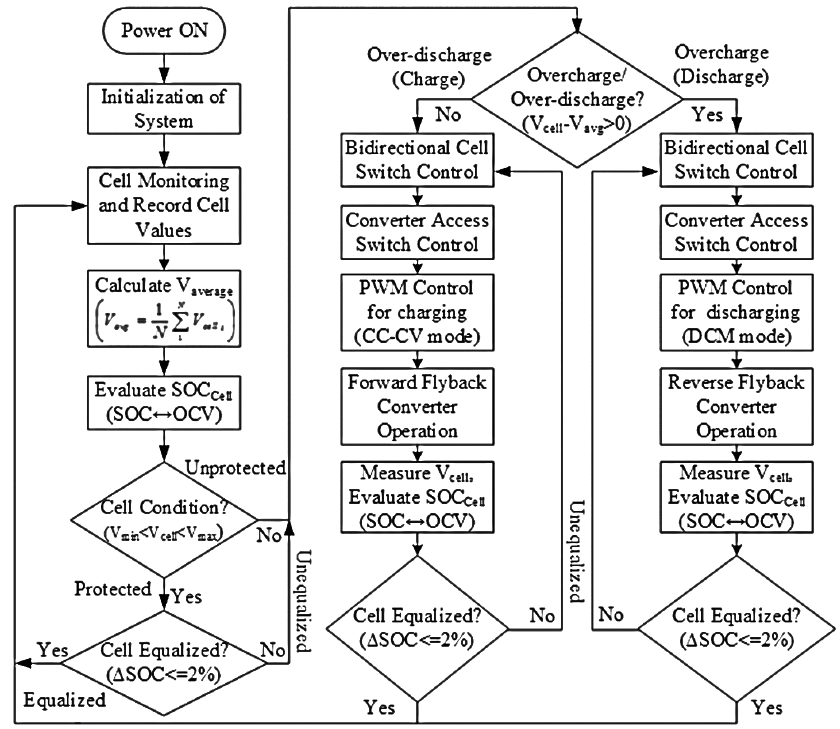
Figure 7. Control algorithm of the flow process of the charge equalization controller.